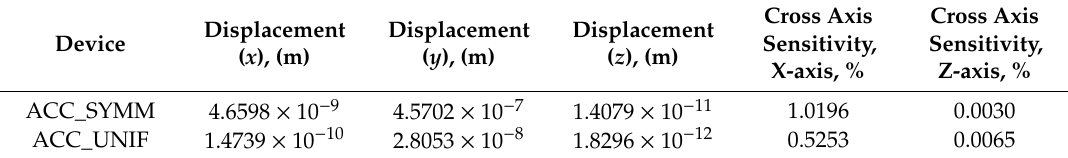
Table 8. Cross-axis